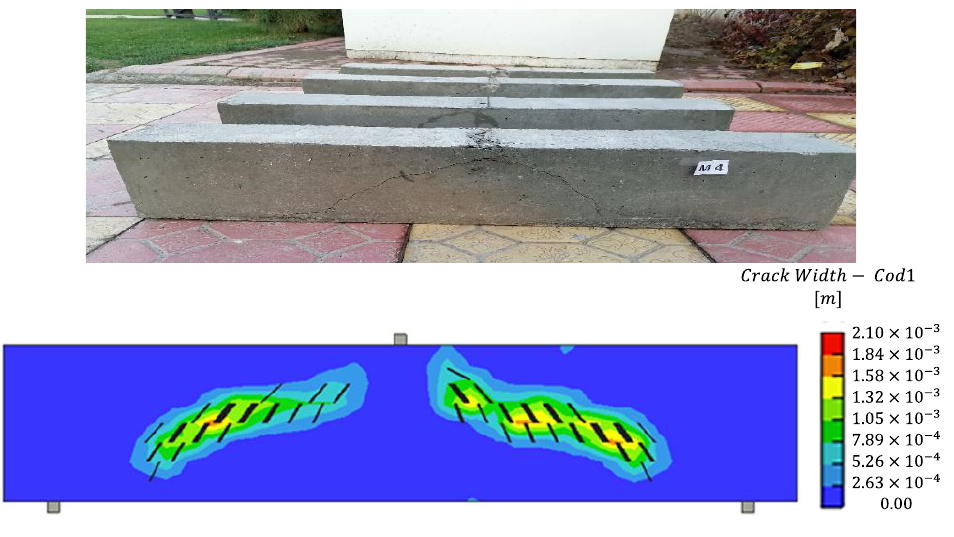
Figure 6. Model M4 verification.